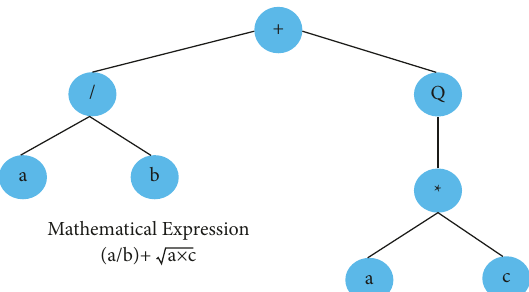
Figure 2: Scheme of ANFIS algorithm.